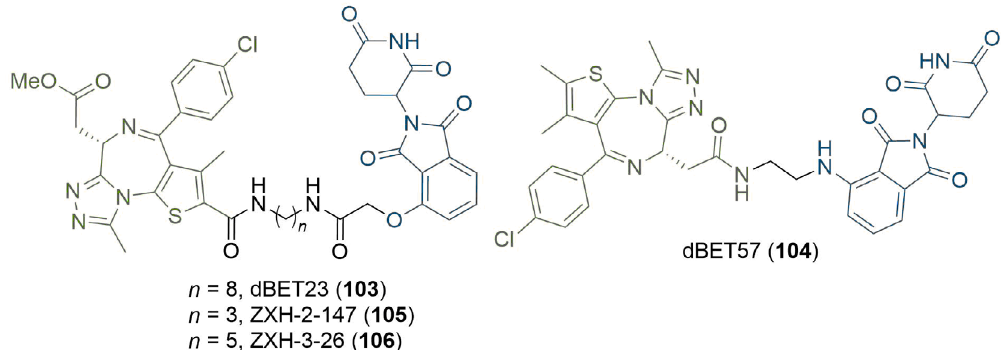
Figure 22. Rational PROTAC design using crystal structures and computational methods. The crystal structures of TC bound 103 and 104, alongside protein-protein docking, revealed potential binding orientations in the TC. Docking was used to identify the shortest distance that could bridge BRD4 and CRBN in the TC, and was used to design 105 and 106